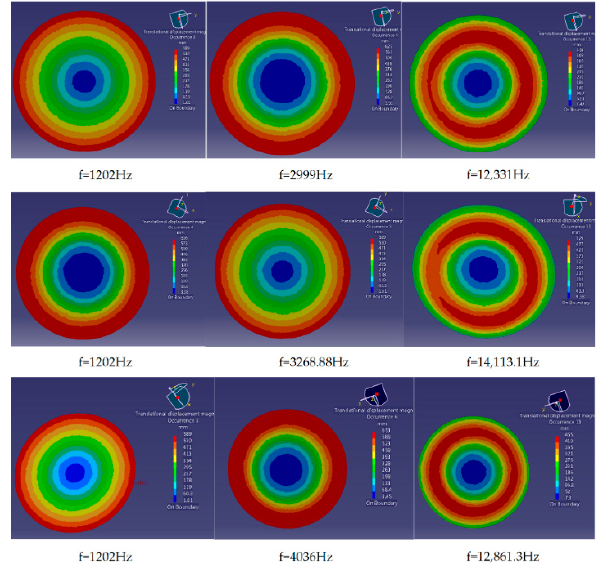
Figure 8. The first three order coupling modal graphs of the sensor filling with different fluids.